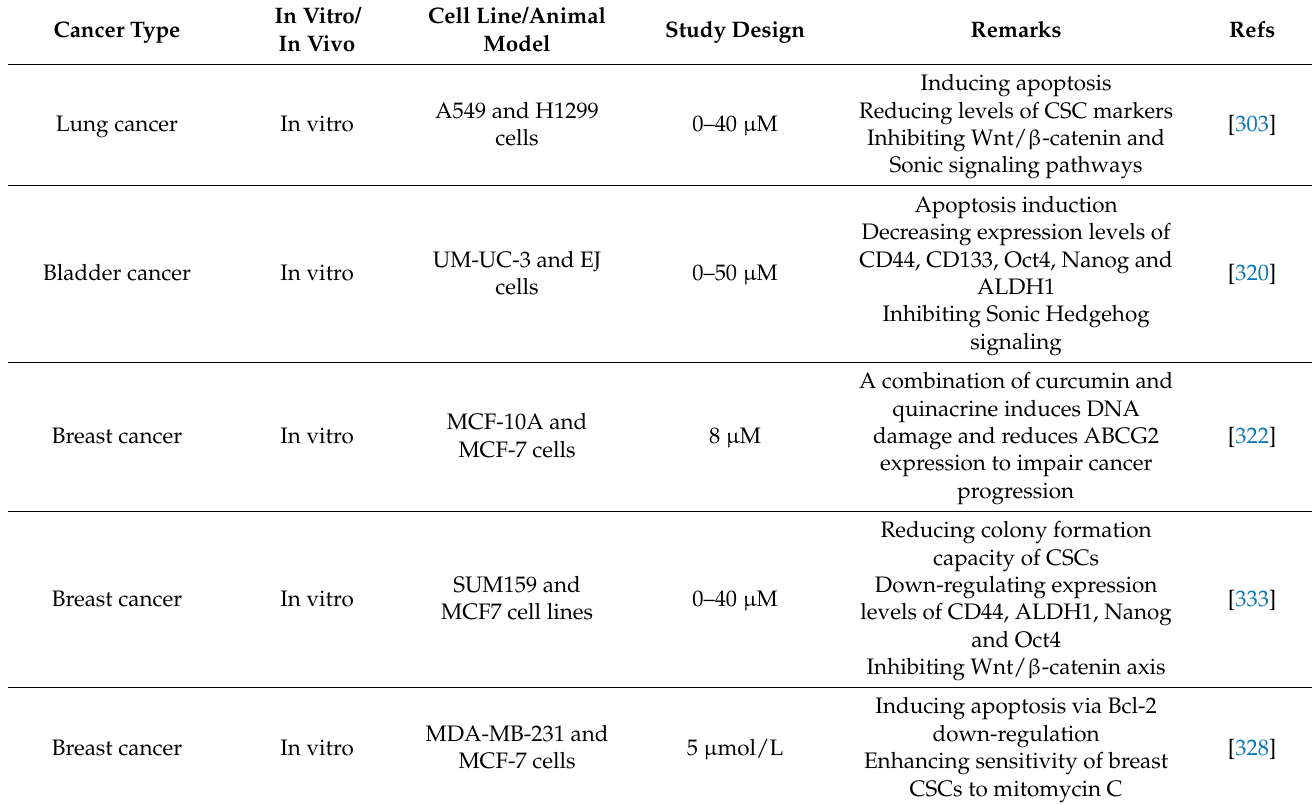
Figure 5. Curcumin in inhibiting CSCs. Table 6. Curcumin potential of suppressing CSCs in tumor